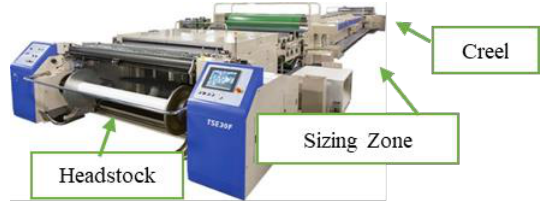
Figure 3. Sizing machine structure.